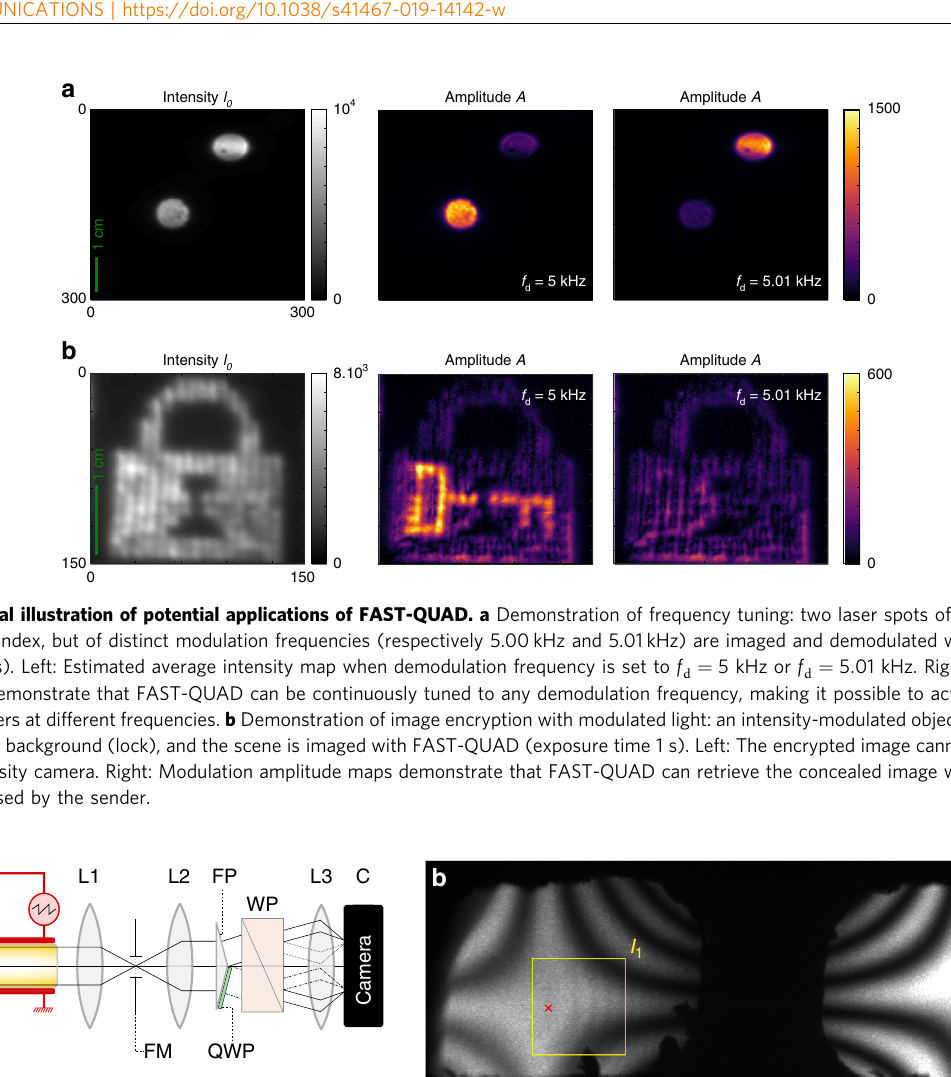
Fig. 5 Presentation of FAST-QUAD prototype. a Schematic and photograph of the FAST-QUAD prototype. Due to the dimensions of the EO crystal employed (2 ´ 2 ´ 40 mm 3 ), it was optimal to have it positioned after the input polarizer P . This was followed by a focusing lens L 1 , a fi eld mask (FM) at the intermediate image (that restricts the image spatial extent to prevent superimposition of the 4 sub-images on the camera), and thereafter a lens L 2 that recollimates the beam. A Fresnel biprism (FP) splits the beam into two, one part of which passes through a quarter-wave plate (QWP). Further propagation through a Wollaston prism results in 4 beams that are imaged onto the camera by means of lens L 3 , providing the four quadrature images. b Example of raw image acquisition when the FAST-QUAD prototype is illuminated with homogeneous light fi eld. The four 300 ´ 300 pixels quadrature sub-images I 1 , I 2 , Q Q 1 and 2 are delineated with yellow frames. The red cross indicates the position of the reference pixel used in Supplementary Note 2 to illustrate the quadrature mismatch correction algorithm with suf fi cient amplitude V . The well-known theory of EO crystals optical phase difference excursion ΔΦ ) has been applied on the electrodes of the provides the relationship between V and the optical phase difference. For EO crystal using a signal generator (Tektronix AFG3252C) and a high-voltage instance, in the case of lithium niobate as used in this prototype, one has 32 ampli fi er (New Focus 3211 High Voltage Ampli fi er, ±200 V, 0 – 0.6 MHz ΔΦ ð V Þ ¼ π ð r (cid:3) r Þ ‘= d λ ´ V , where r ’ 10 pm.V (cid:3) 1 and r ’ 30 pm. 3 3 bandwidth). 13 n 33 n 13 33 O E Due to the importance of the ratio of the length and thickness/breadth of the V (cid:3) 1 correspond to (Pockel ’ s) electro-optic coef fi cients of LiNbO 3 (approximate crystal, the best option in terms of FOV and resolution consisted of placing the EO values in the visible range) 33 . The ordinary, respectively, extraordinary, optical crystal just after the input polarizer P (Thorlabs, LPVISB050), before the image was refractive indices of LiNbO 3 are n O ’ 2 : 32 and n E ’ 2 : 23 at λ ¼ 532 nm 33 . To focused by lens L 1 in an intermediate image plane where a fi eld mask has been limit the voltage amplitude to reasonable values (i.e., within the 100 (cid:3) 200 V inserted to restrict the spatial extent of the image so that the 4 sub-images do not range), we selected a LiNbO 3 EO crystal (Moltec GmbH) of length ‘ ¼ 40 mm and overlap at the camera (See Fig. 5a). The light is re-collimated through objective lens with a 2 ´ 2 mm 2 aperture section ( d ¼ 2 mm). A high-voltage sawtooth waveform L 2 and split with a Fresnel bi-prism (NewLight photonics, 160 (cid:1) apex angle) and a (with peak-to-peak amplitude of 124 V calibrated to provide exact 360 (cid:1) maximum